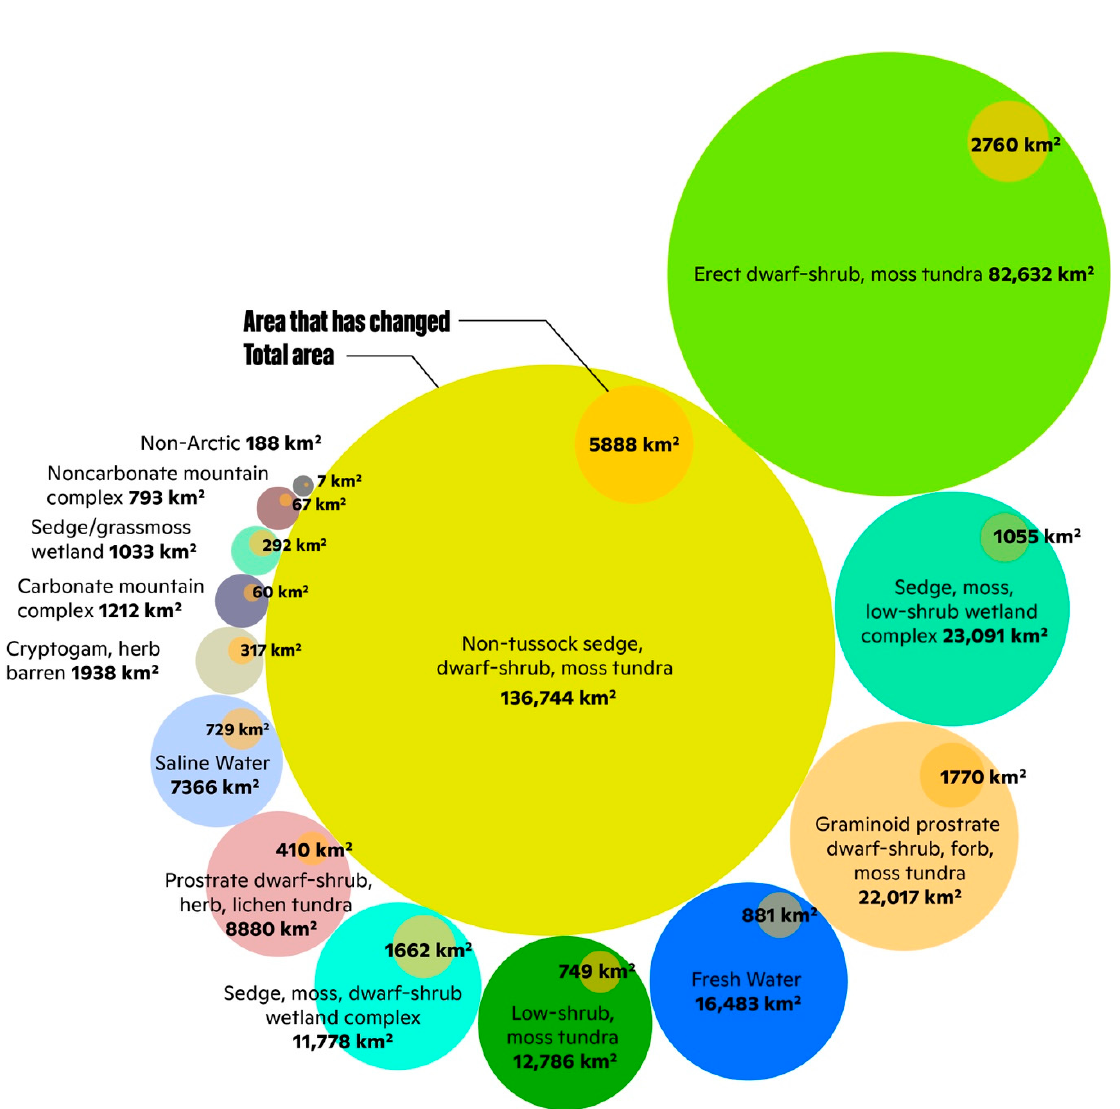
Figure A2. Area of landscape change visualized as a proportion of total area, for categories of land surface types ( n = 14) within the study area. Land surface categories were extracted from the circumpolar arctic vegetation map [27].